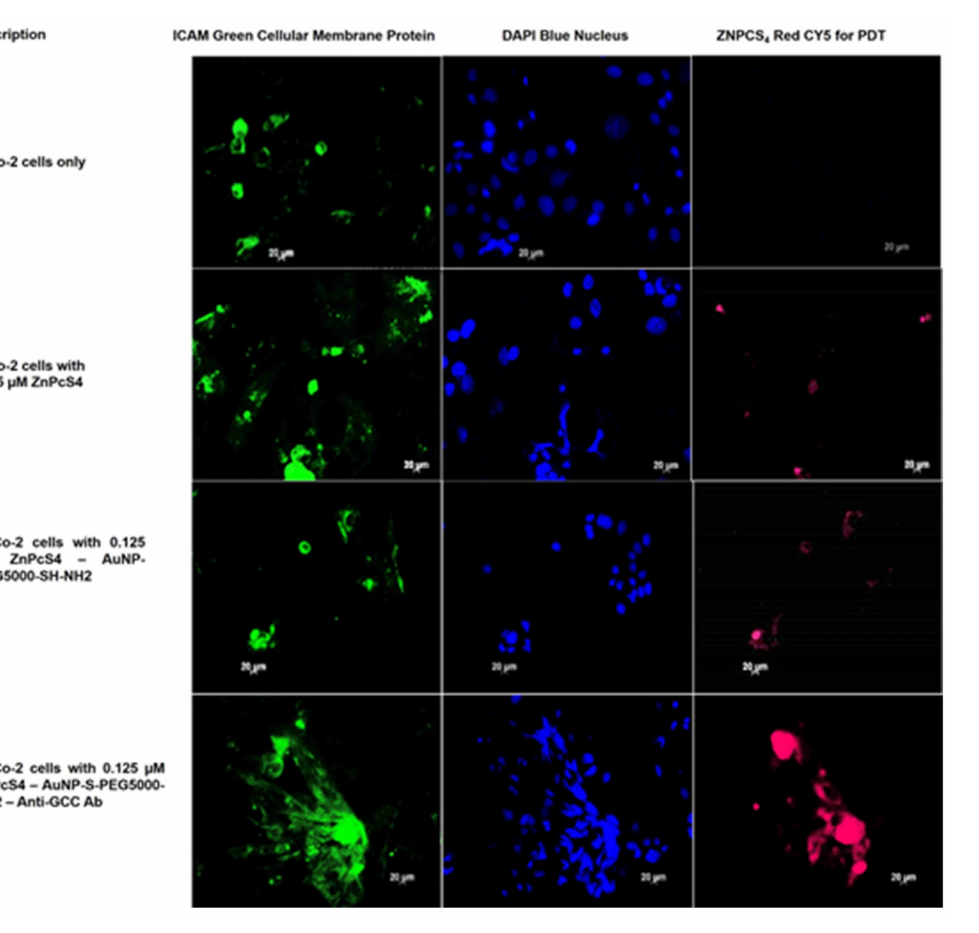
Figure 5. Subcellular localization images comparison of ZnPcS 4 PS uptake in CaCo-2 cells, treated with ZnPcS 4 PS alone, AuNP-S-PEG5000-NH 2 -ZnPcS 4 , and the final BNC. DAPI-stained nuclei (blue), cellular ICAM membrane proteins (green), and ZnPcS 4 PS localization